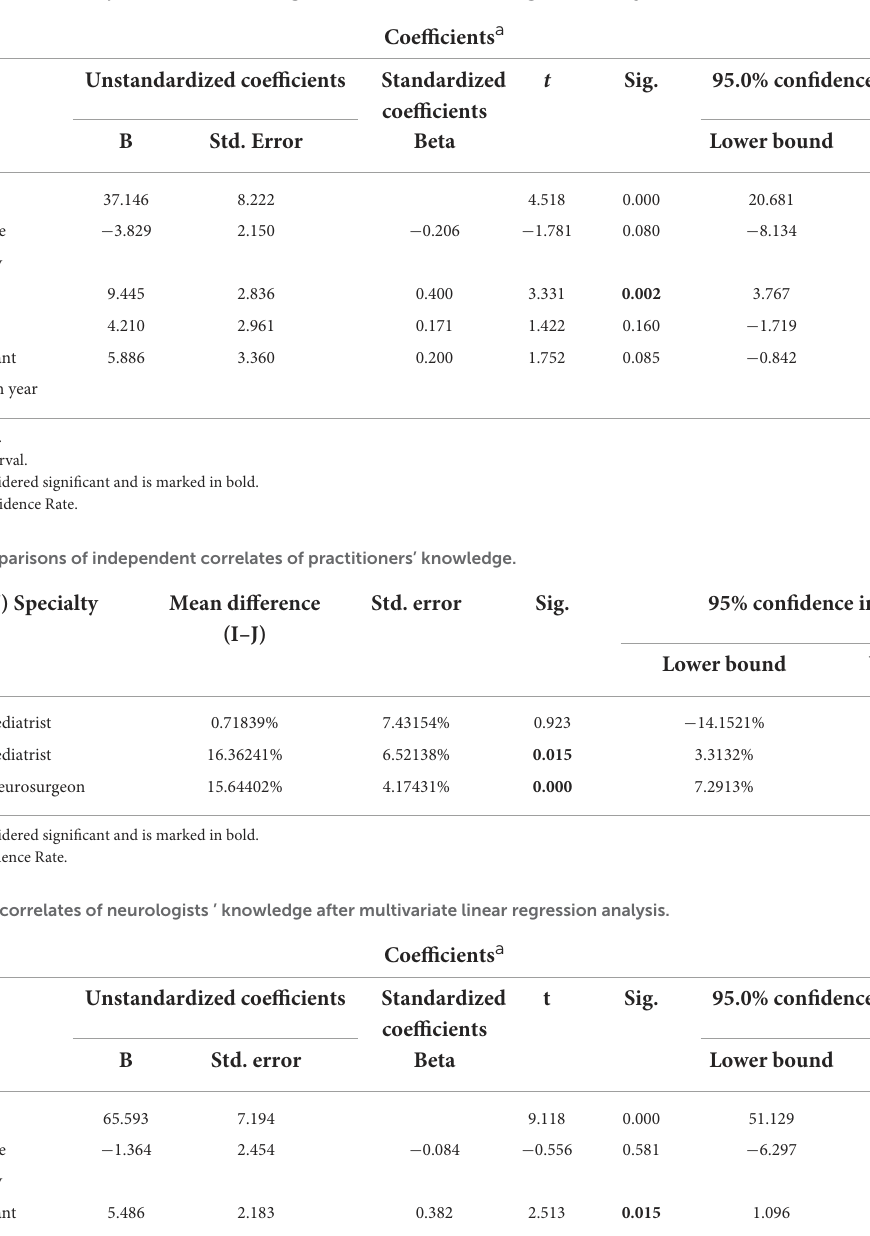
TABLE 4 Independent correlates of practitioners’ knowledge after multivariate linear regression analysis.